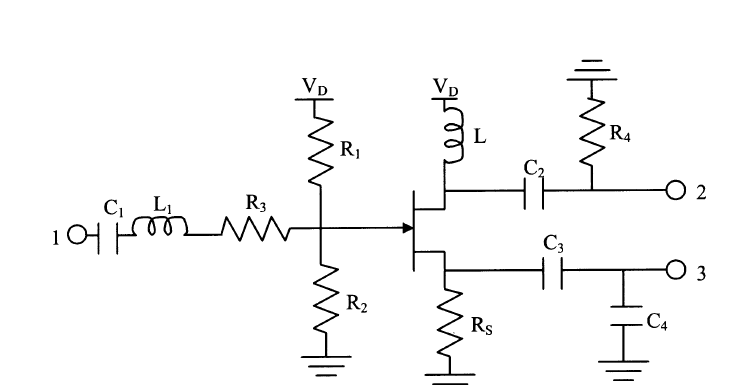
FIGURE 24 DC biased circuit.